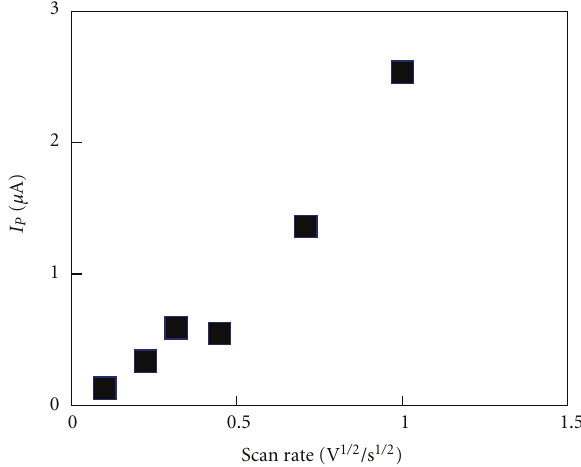
Figure 4: E ff ect of scan rate to the anodic oxidation of bisphenol A. Anodic peak potentials of 0.1mM bisphenol A at pH 7.0 were plotted.